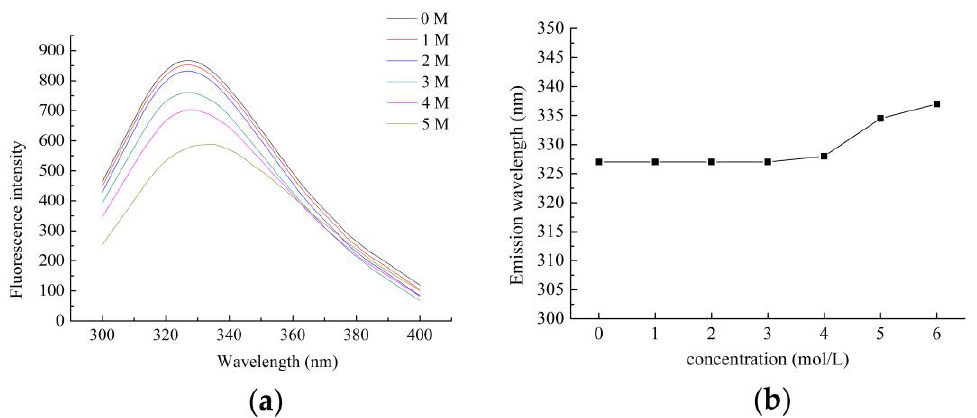
Figure 9. The fluorescence spectra ( a ) and maximum emission wavelength ( b ) of the lectin at different GdnHCl concentrations.